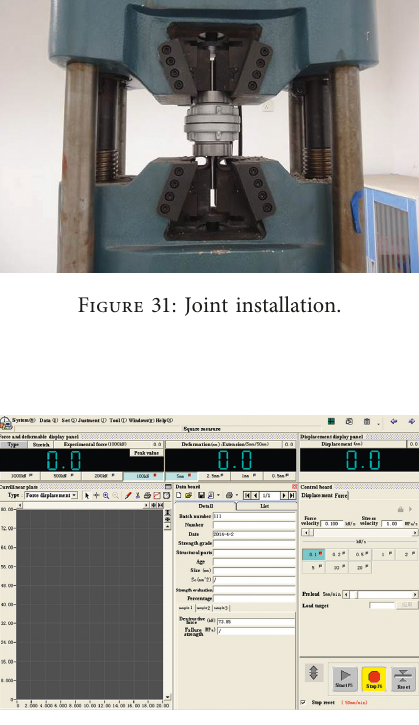
Figure 32: Software